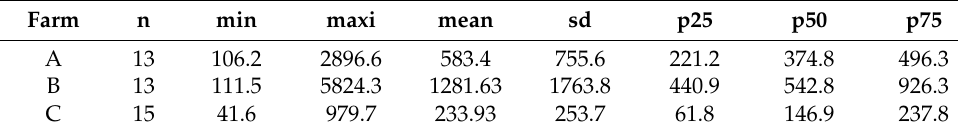
Table 7. Descriptive statistics of plasma BDNF concentration by